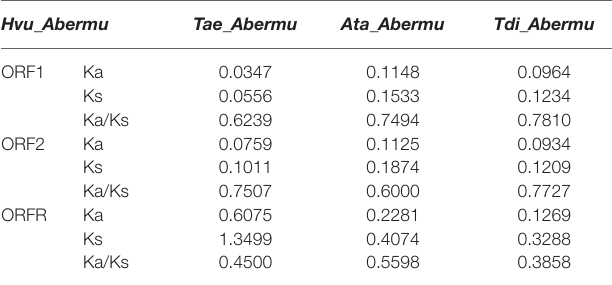
TABLE 2 | Ka and Ks values of three ORFs between Hvu_Abermu and its three homologs. Hvu_Abermu